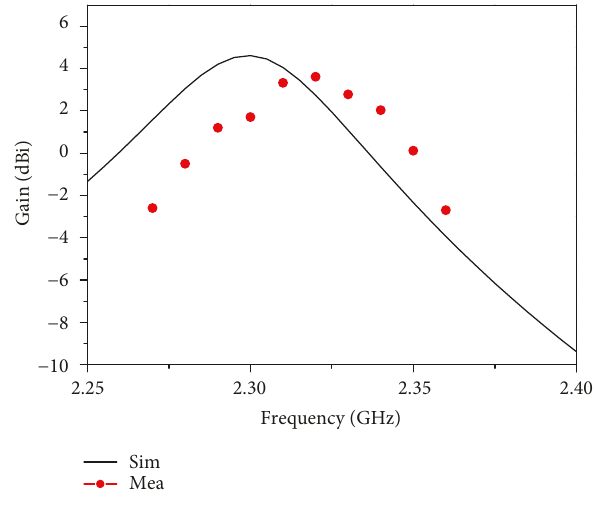
Figure 10: Simulated and measured